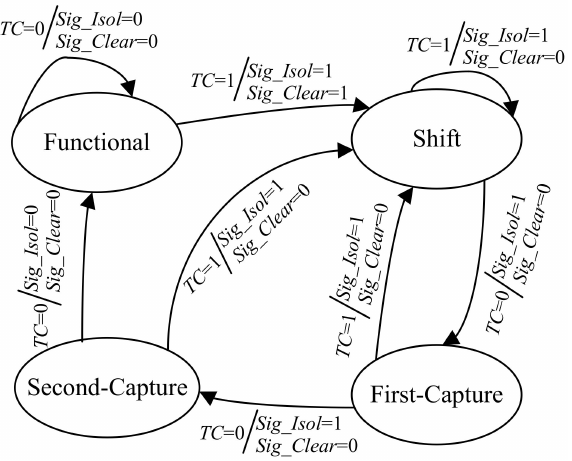
Figure 3. State diagram of automatic test control